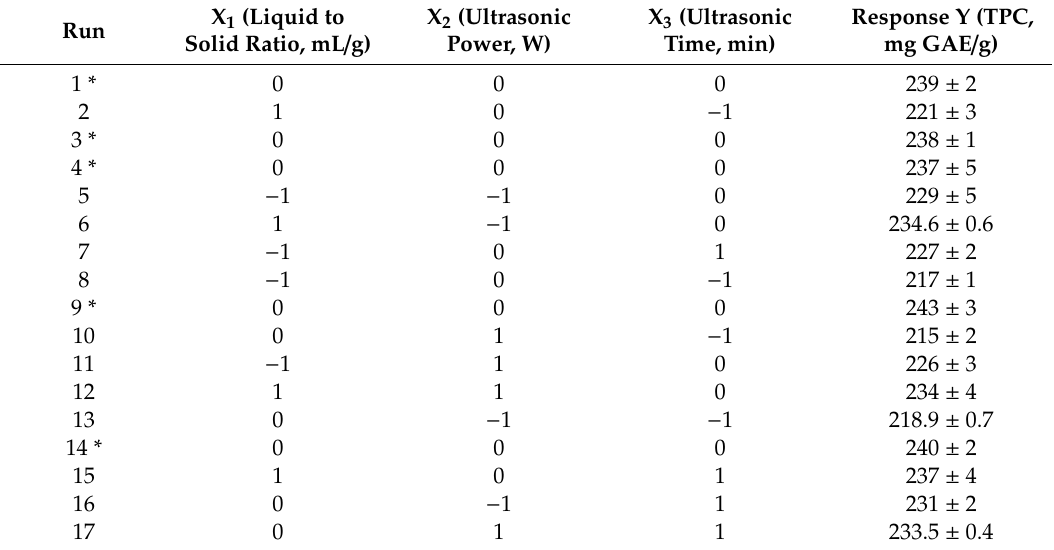
Table 3. Experimental runs and the results of the response